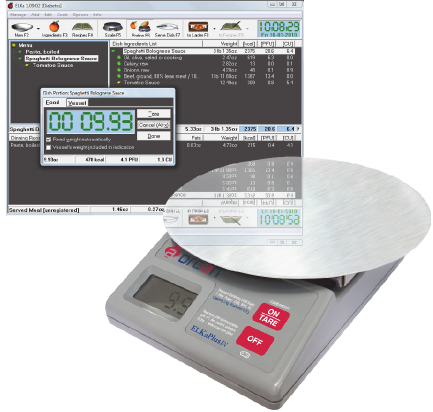
Figure 1: The ELKa